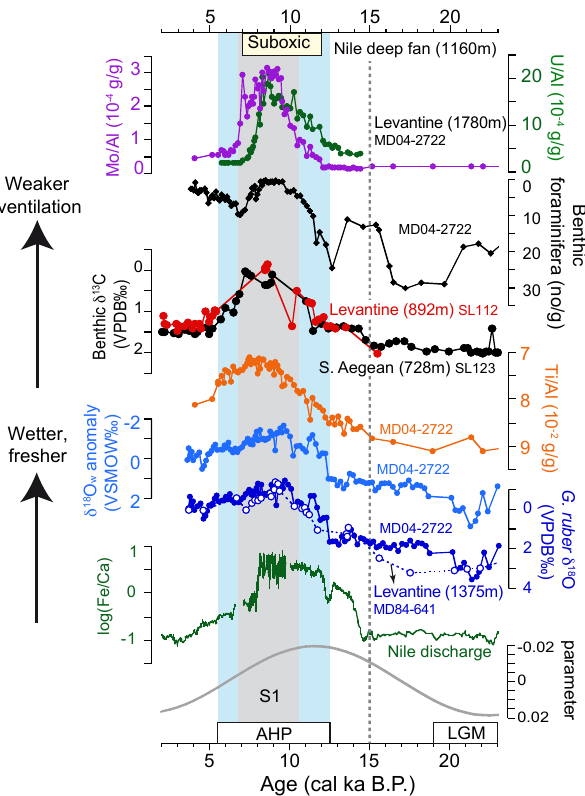
Figure 4. The last 23kyr variability of proxies for ventilation (U / Al, Mo / Al and benthic foraminiferal density) and wet or fresh conditions (Ti / Al and seawater δ 18 O anomaly) based on core MD04-2722 results as compared with previous studies. The sur- face water δ 18 O anomaly was calculated by combining the G. ru- ber δ 18 O record from core MD04-2722 with the SST reconstruction (see text for detail). Suboxic conditions on the Nile deep fan were estimated to have lasted from 12 to 7calkaBP at the “buildups”’ location (Fig. 1a and b) (Bayon et al., 2013). Benthic foraminiferal δ 13 C records were based on the epibenthic foraminifer species Planulina ariminensis (Kuhnt et al., 2007; Schmiedl et al., 2010). Changes in Nile River discharge are shown with the log scale Fe / Ca ratio for core MS27PT, located close to the Rosetta Mouth of the Nile River (Revel et al., 2014). The precession parameter is from Laskar et al. (2004). The blue zone indicates the African Hu- mid Period (AHP, 12.5–5.5calkaBP) based on Adkins et al. (2006) and deMenocal et al. (2000). The grey band indicates the S1 pe- riod from 10.4 to 6.8calkaBP, estimated for core MD04-2722. The dashed line presents the possible onset for weaker ventilation at 15calkaBP in the eastern Mediterranean Sea. LGM: Last Glacial